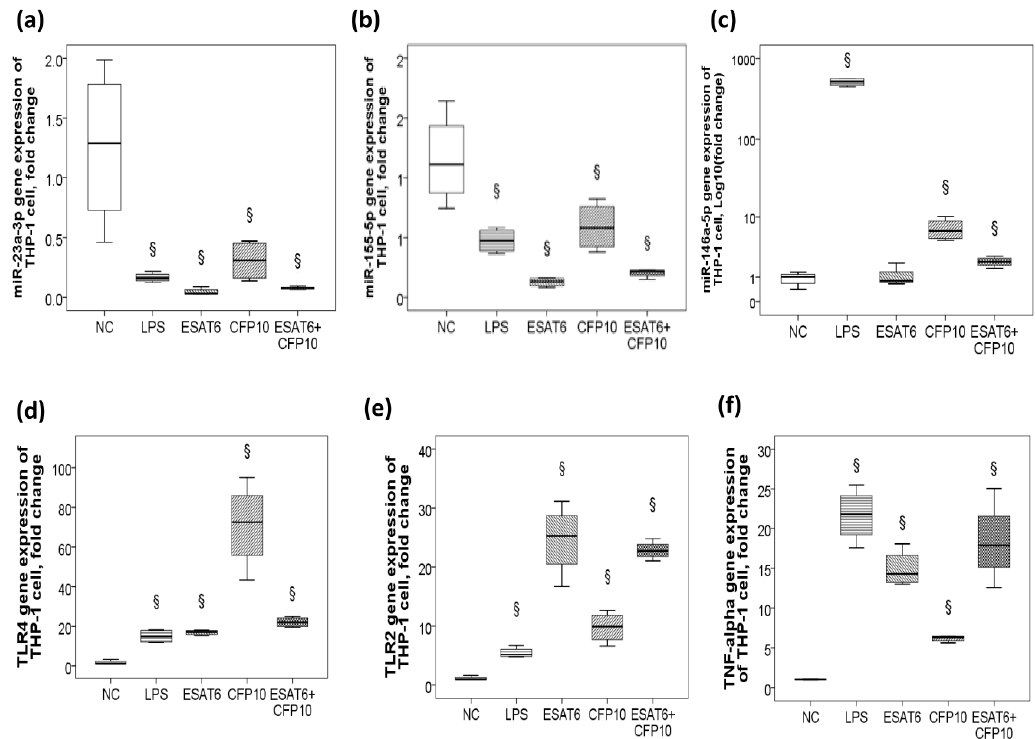
Figure 2. Differential gene expressions of the five microRNAs targeting the toll-like receptor pathway in response to Mycobacterium TB-specific antigen stimuli in vitro. In vitro ESAT6, CFP10, and lipopolysaccharide (LPS) stimuli in THP-1 cells resulted in down-regulations of ( a ) miR-23a-3p and ( b ) miR-155-5p, and up-regulations of ( c ) miR-146a-5p, ( d ) TLR4, ( e ) TLR2, and ( f ) tumor necrosis factor (TNF)- α . § p < 0.05, compared with normal control (NC; culture medium) by Kruskal–Wallis H test.